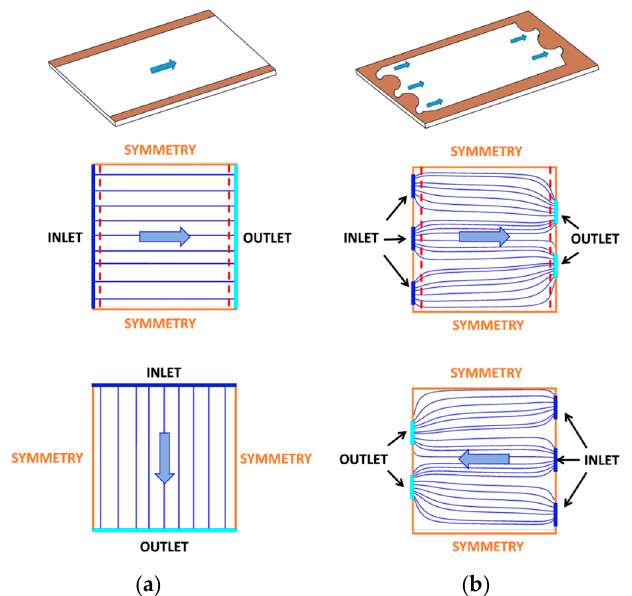
Figure 8. The flow arrangements analyzed in the present work. ( a ) cross flow; ( b ) counter flow. The insets in the top row show the actual geometry of inlets and outlets. The second and third rows report the approximated geometry simulated here that apply to the two solutions (e.g., concentrate and diluate). The broken lines in the middle graphs are those along which the velocity and pressure profiles obtained with different grids were compared (Appendix B).